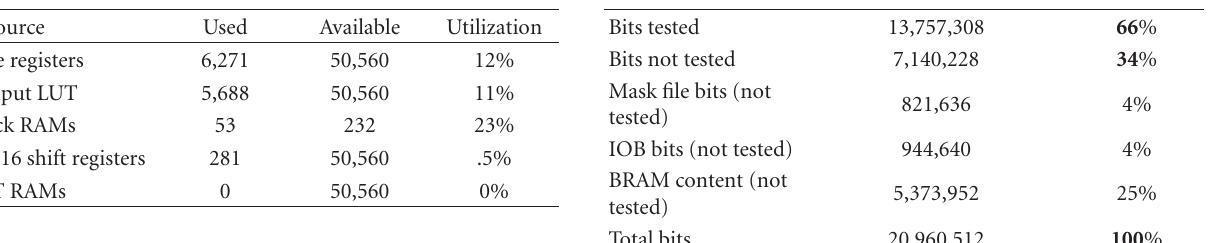
Table 3: Device logic utilization. Table 4: Summary of bits tested/not tested.